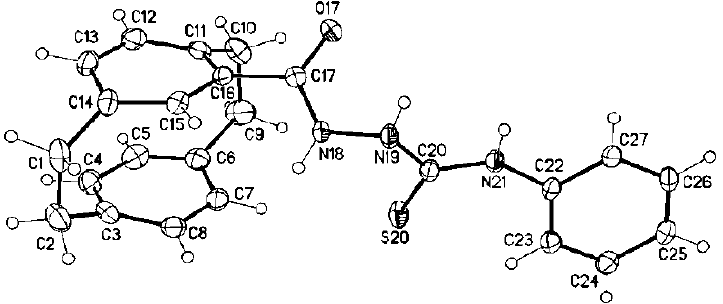
Figure 4. Molecular structure of compound 2a identified according to IUPAC nomenclature as 2-